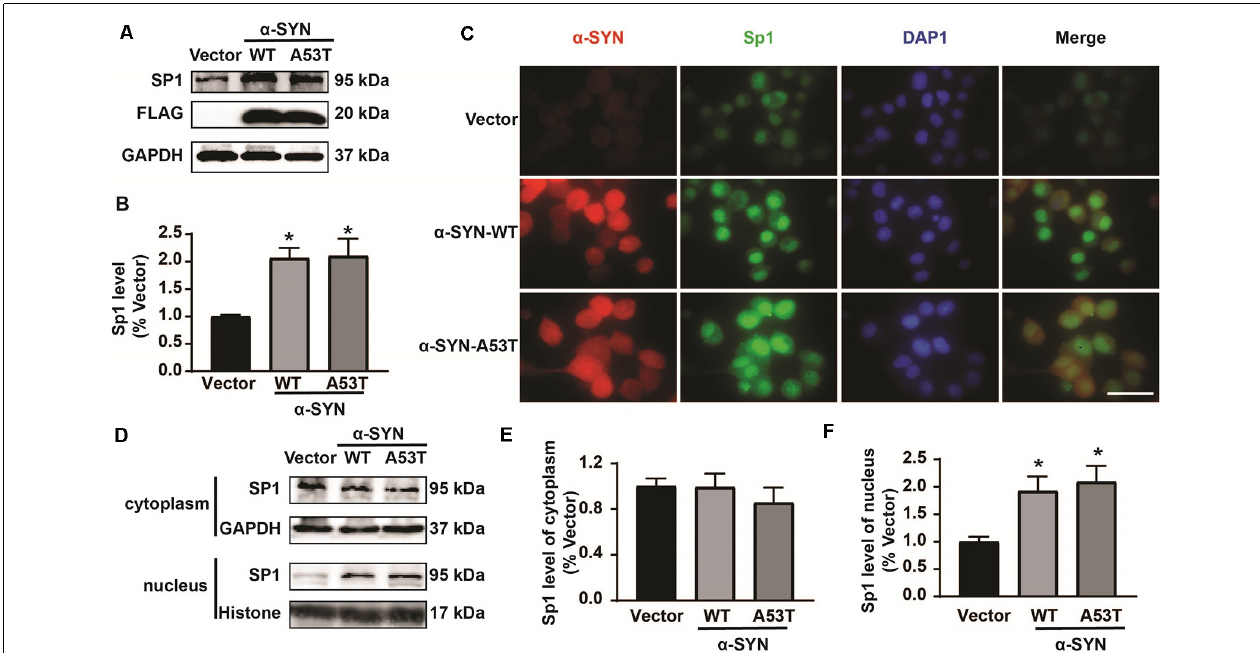
FIGURE 5 | α -SYN regulated the expression of Sp1. Western blot was used to detect the protein level of Sp1 in control cells (Vector), α -SYN WT and α -SYN A53T stably overexpressed cells (A,B) . The intracellular protein level of Sp1 was confirmed using immunofluorescent staining, α -SYN (red), Sp1 (green), and nucleus (blue).